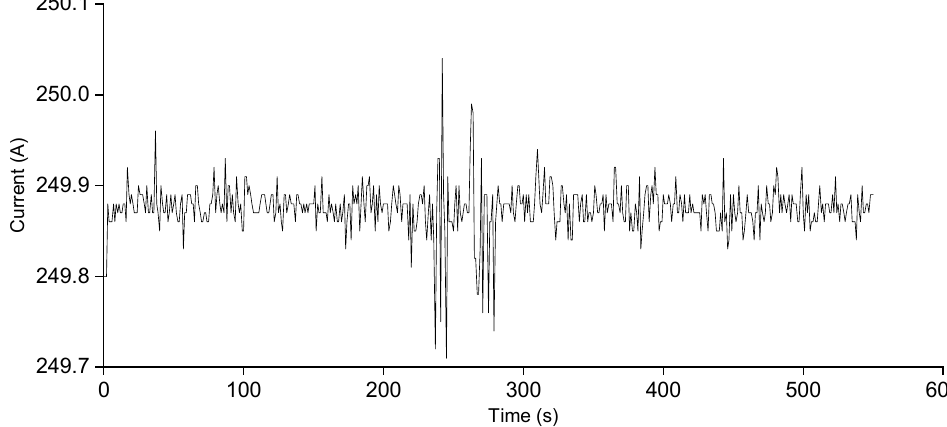
Figure 2. Measured electric current through the battery under 5C discharge rate. The DOD is the percentage of the battery capacity that has been discharged from the fully charged battery as presented in Equation (4). An alternative form of DOD is the state of charge ( SOC ), wherein 0% refers to a fully discharged battery and 100% refers to a fully charged battery, as shown in Equation (5) and Figure 3a.